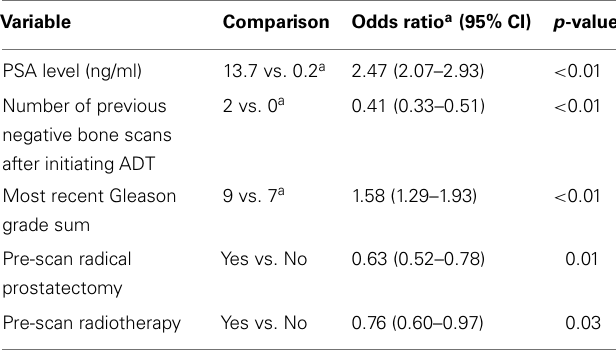
Table 3 | Multivariable logistic regression analysis of the variables included in the nomogram model